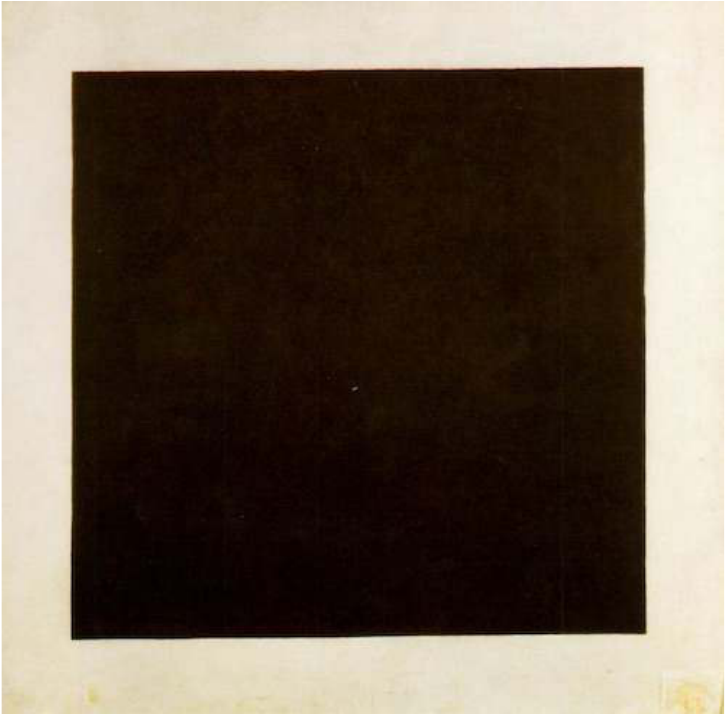
Figure 2. Kasimir Malevich, Black Square (1915)